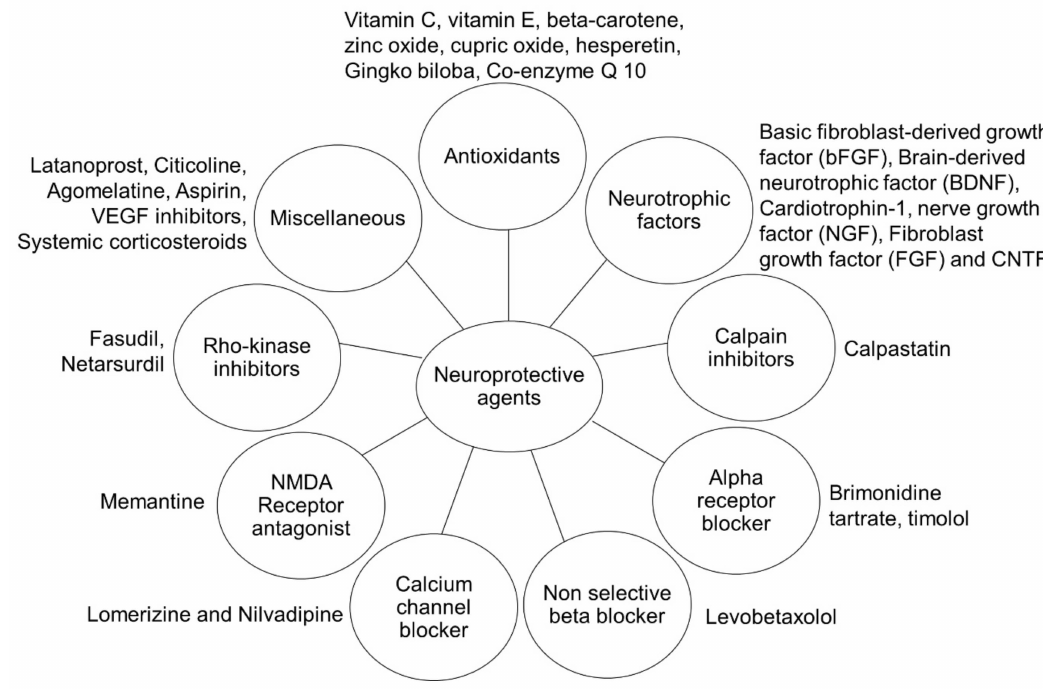
Figure 2. Neuroprotective agents in the treatment of ocular